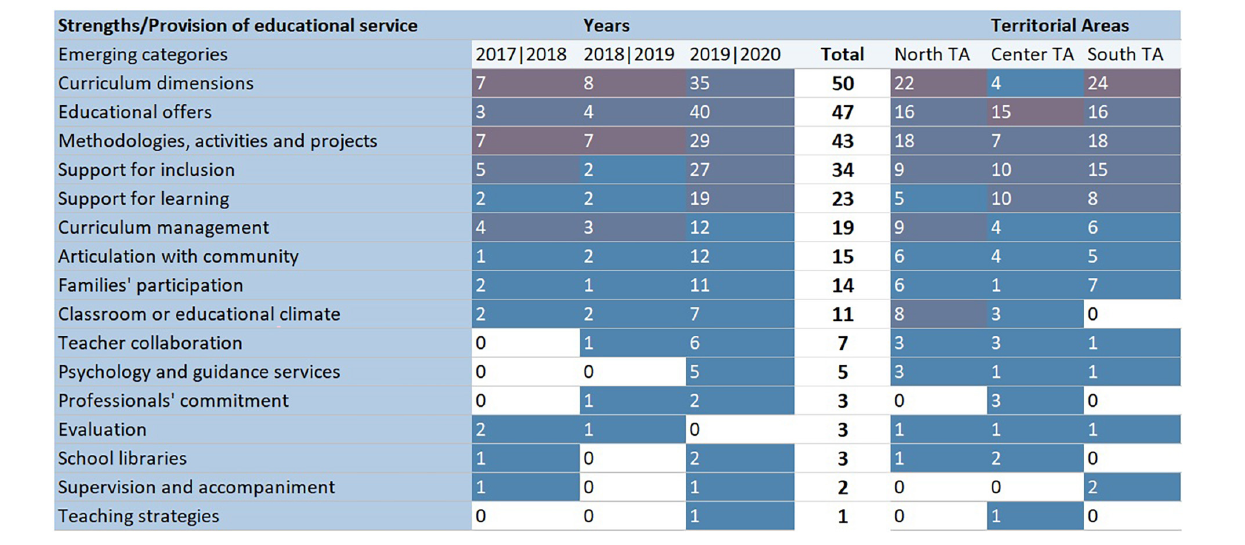
FIGURE 7 | Provision of educational service: strengths. The distribution of coded segments by subcategories, year, and